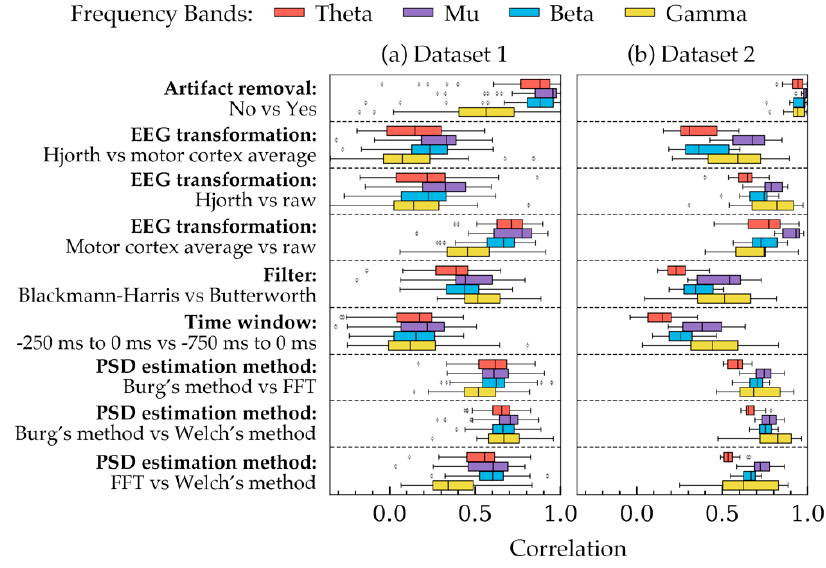
Figure 2. Correlations between di ff erent choices of each method are demonstrated for all subjects in both datasets. Each frequency band was considered separately while calculating the correlations. The four bands are highlighted with four di ff erent colors. For each method (presented in each row), the remaining methodological choices were kept constant as follows: artifact removal = yes, EEG transformation = raw, filter = Butterworth, time window = 750 ms, and PSD estimation method = Welch’s method. The boxes indicate the quartiles of the samples while the whiskers extend to show the rest of the distribution up to 1.5 inter-quartile range. The dots indicate the outliers. ( a ) The correlations obtained from all subjects of Dataset 1. ( b ) Correlations obtained from all subjects in Dataset 2. Table 1. The results of 40 linear mixed e ff ect models (20 for Dataset 1 and 20 for Dataset 2), where the response variable was the PSD. The e ff ects of choices in artifact removal, EEG transformations, filters, time windows, and PSD estimation methods are outlined in the table. The e ff ects are shown separately for each frequency bands. Significant p -values are marked with asterisks (*). Dataset 1 Dataset 2 Factor Model Number Band p F p F Artifact removed